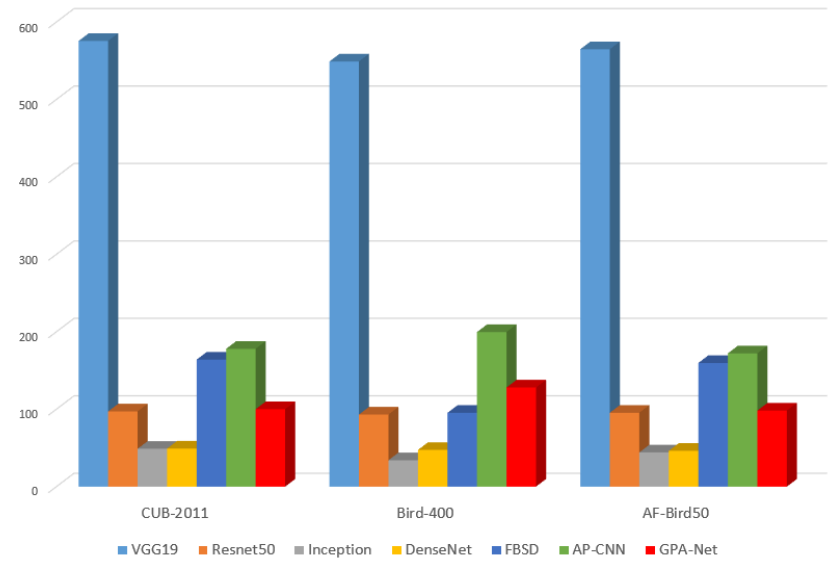
Figure 6. Parameter comparison chart of different models.